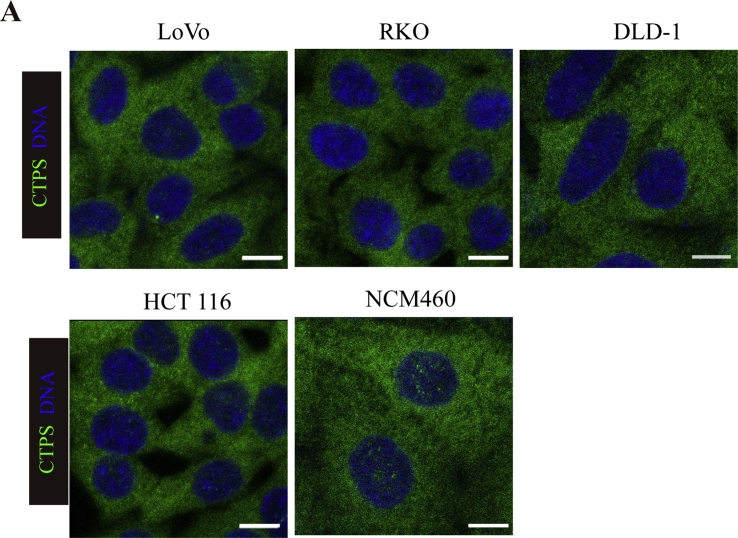
The distribution of CTPS in other colorectal cancer and colon mucosal epithelial cells. The indicated cell lines were cultured under normal culture conditions for 48 h and then fixed and subjected to immunofluorescence analysis with anti-CTPS antibody (green). Nuclei were labeled with DAPI (blue). Scale bar: 10 μm. DAPI, 40,6-diamidino-2-phenylindole.